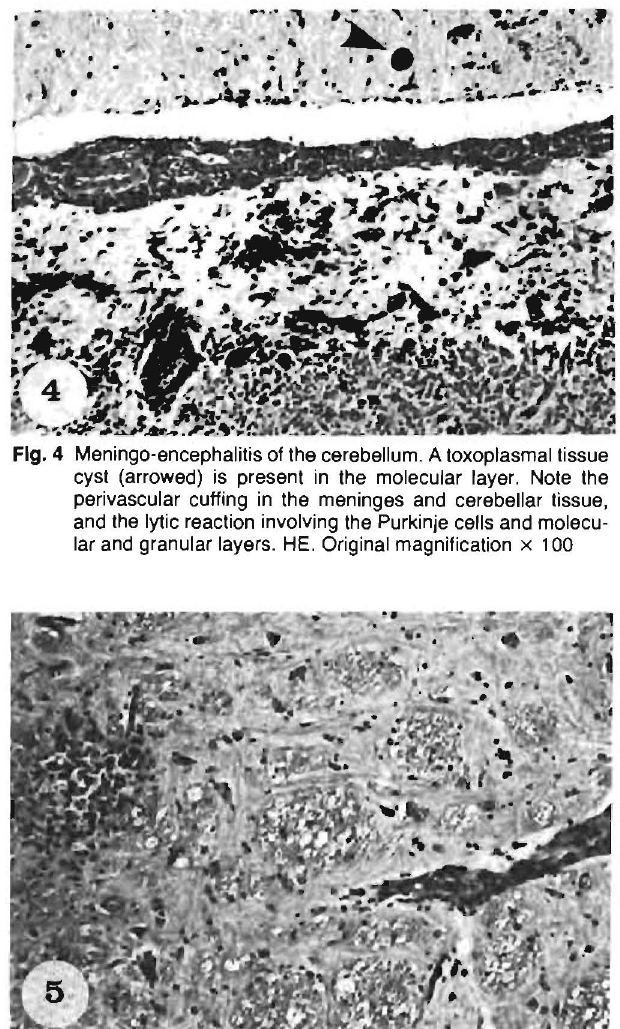
Fig. 5 Perivascular cuffing. glial nodule and status spongiosus in the medulla oblongata. HE. Original magnification x 100